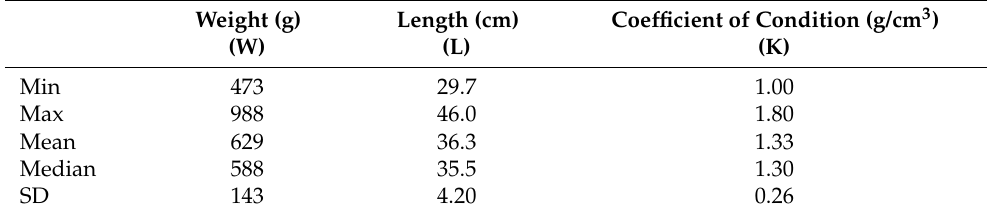
Table 1. Values of biometric parameters in Catla catla . Weight